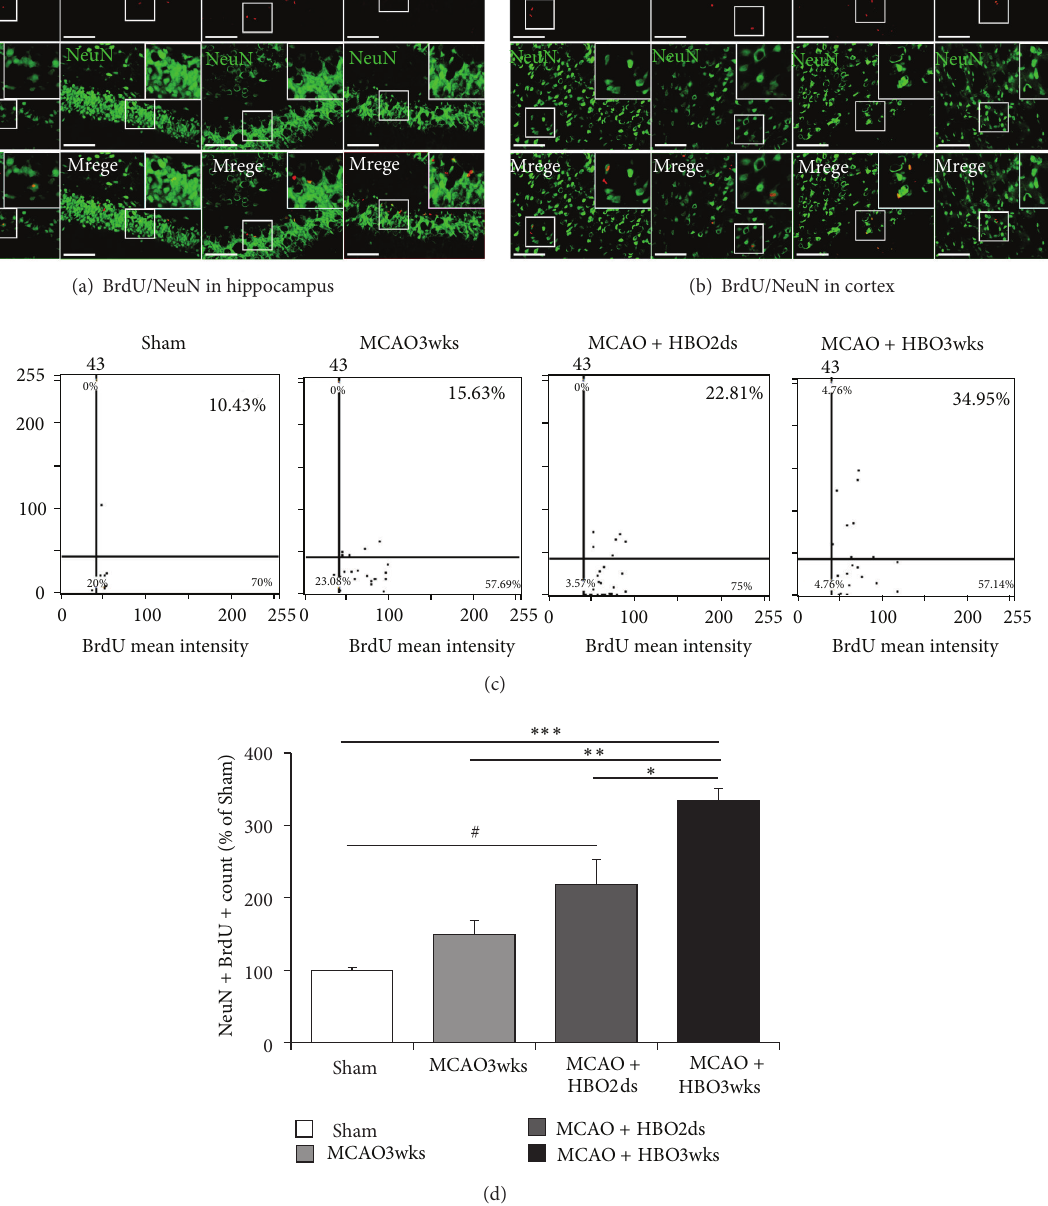
Figure 4: Long course HBO increased neurogenesis. ((a) and (b)) BrdU-NeuN double staining showed that there were significantly more newly forming neurons in the ischemic boundary area (perilesioned cortex (Figure 4(b)) and hippocampus (Figure 4(a))) of HBO3wks rats than HBO2ds rats. (c) Representative images of tissue cytometry using TissueQuest software. BrdU-NeuN positive cells were counted and the signal intensity was quantified. The intensity of co-staining with BrdU and Neu-N was more prominent in HBO3wks group. The difference was significant, as compared with MCAO3wks group and HBO3wks group ( ∗∗ 𝑃 < 0.01 ). There was still significant difference between HBO2ds group and HBO3wks group ( ∗ 𝑃 < 0.05 ). The difference was even more significant as compared with Sham group and HBO3wks group ( ∗∗∗ 𝑃 < 0.001